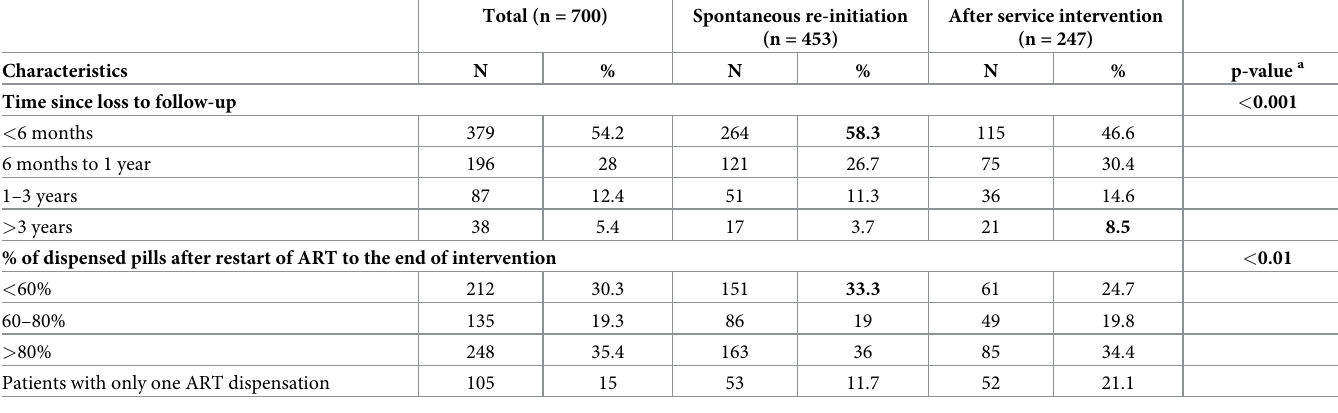
Table 4. Characteristics of patients who were lost to follow-up and restarted therapy (n =